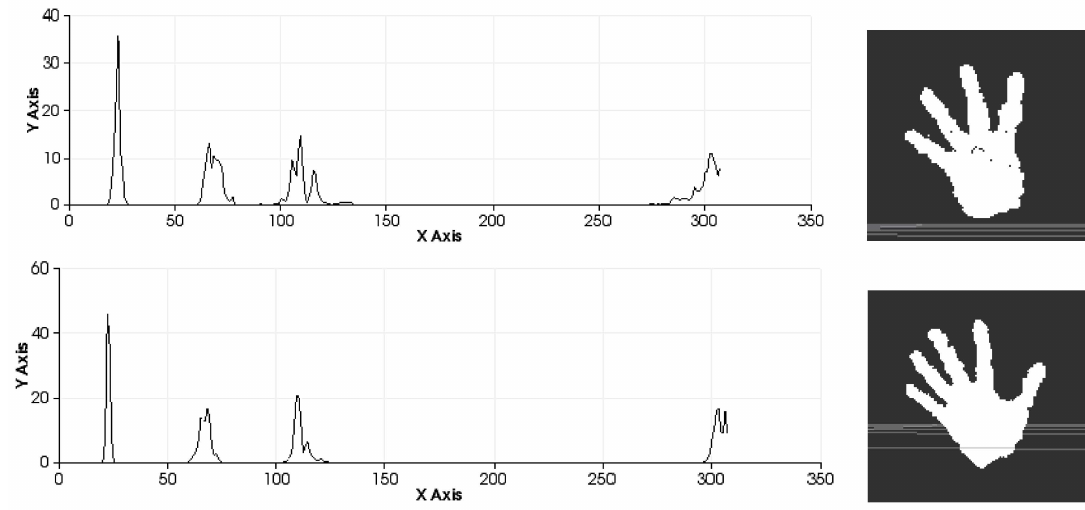
Figure 10. Sets of descriptors computed to recognise several left-hand gestures II. Descriptor in the left. Pose in the right.